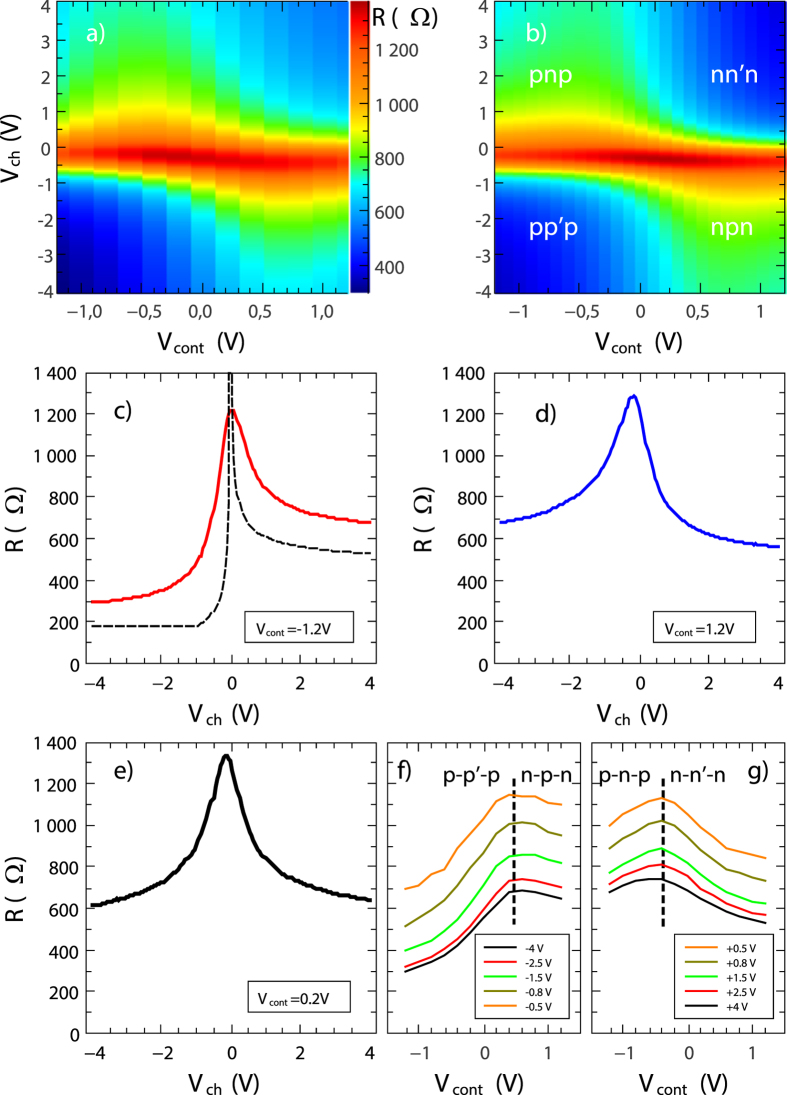
DC operation of the contact gated transistor.Panel (a): color map of the device resistance as a function of contact and channel gate voltages. Panel (b): Corresponding simulation using the fitting model and parameters described in the text. Panels (c–e): Typical resistance transfer curves for a subset of contact gate voltages. The asymmetry of curves in panels (c,d) reflects the p and n doping of the contact; the symmetry of curve in panel (e) suggests a neutral contact. The dotted line in panel (c) represents the transfer curve expected from a fully ballistic device. Panels (f,g): Device resistance as a function of contact gate voltage for channel gate voltages Vch = −4 V→−0.5 V and Vch = +4 V→+0.5 V (from bottom to top) respectively.